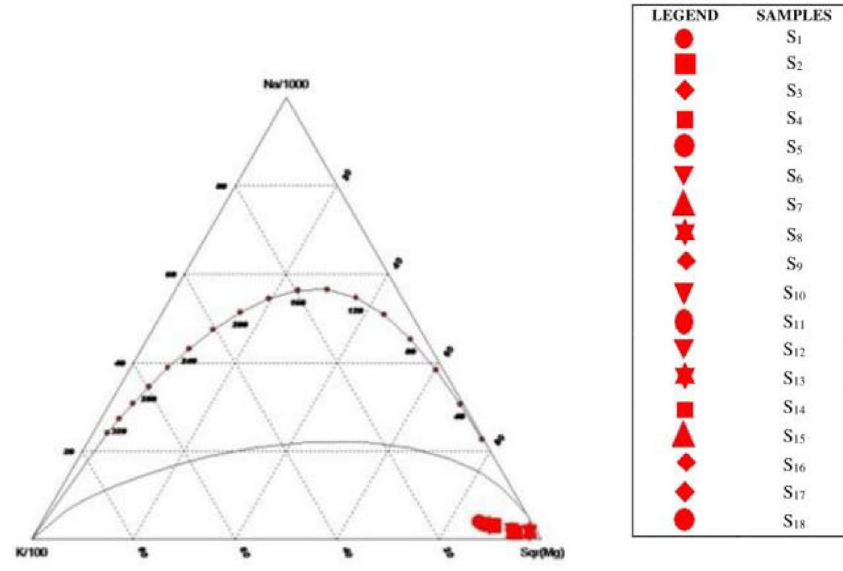
Fig. 4 Giggenbach triangle diagram of 18 groundwater samples of Batlagundu block in Dindigul